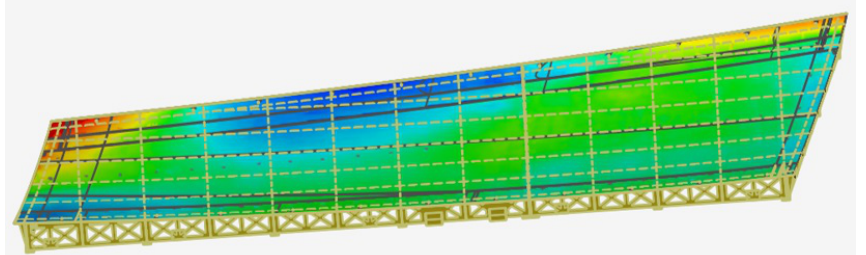
Figure 9. Comparison of measured mold tool surface sized 9 × 2.1 m with CAD data. The deviations are about 2 (red) and − 2 mm (blue) caused by tweaking the frame support beneath the tool. Reprinted with permission from Reference